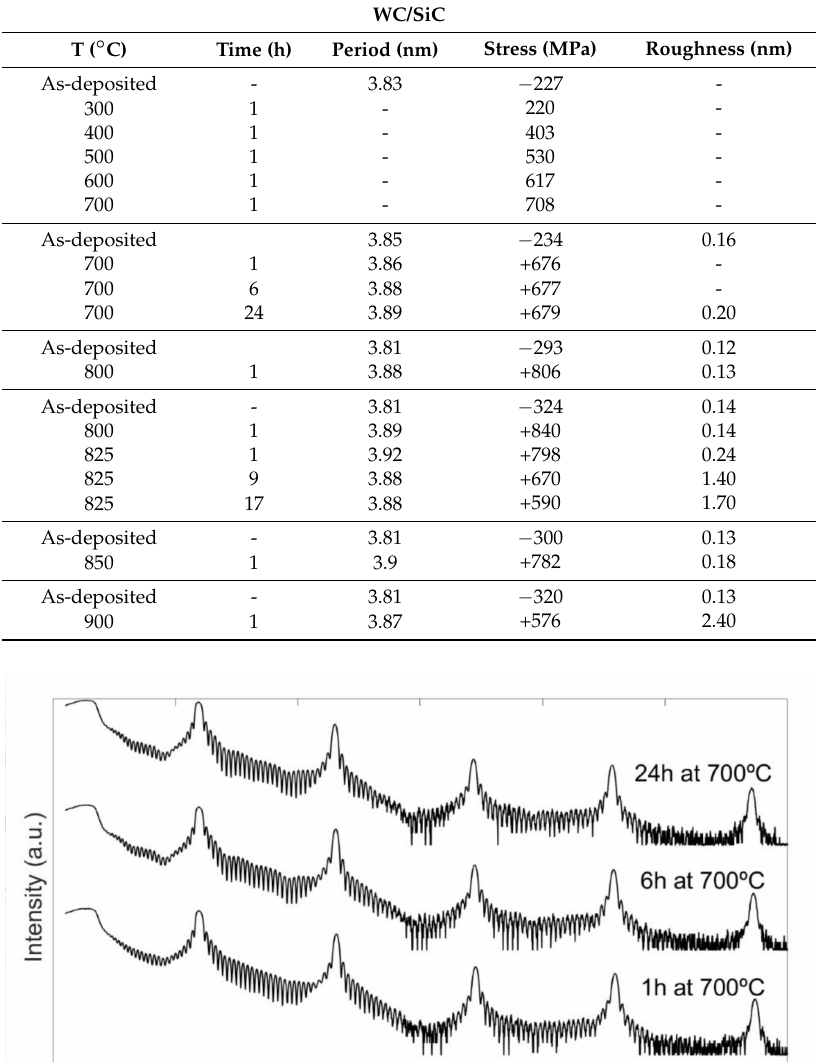
Table 3. WC/SiC multilayer period, stress and surface roughness as a function of annealing temperature. Data after “as-deposited” originate from the same sample. Data from six different, short period samples are shown here. Roughness is AFM measured surface roughness.